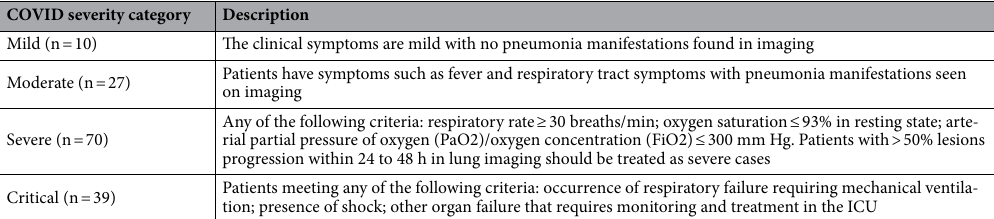
Table 1. Patients in the study cohort, as classified by the Hospital del Mar clinical care team. The WHO COVID-19 Guidance 2021 19 was used to define the COVID severity categories. There were a total of 146 patients in the